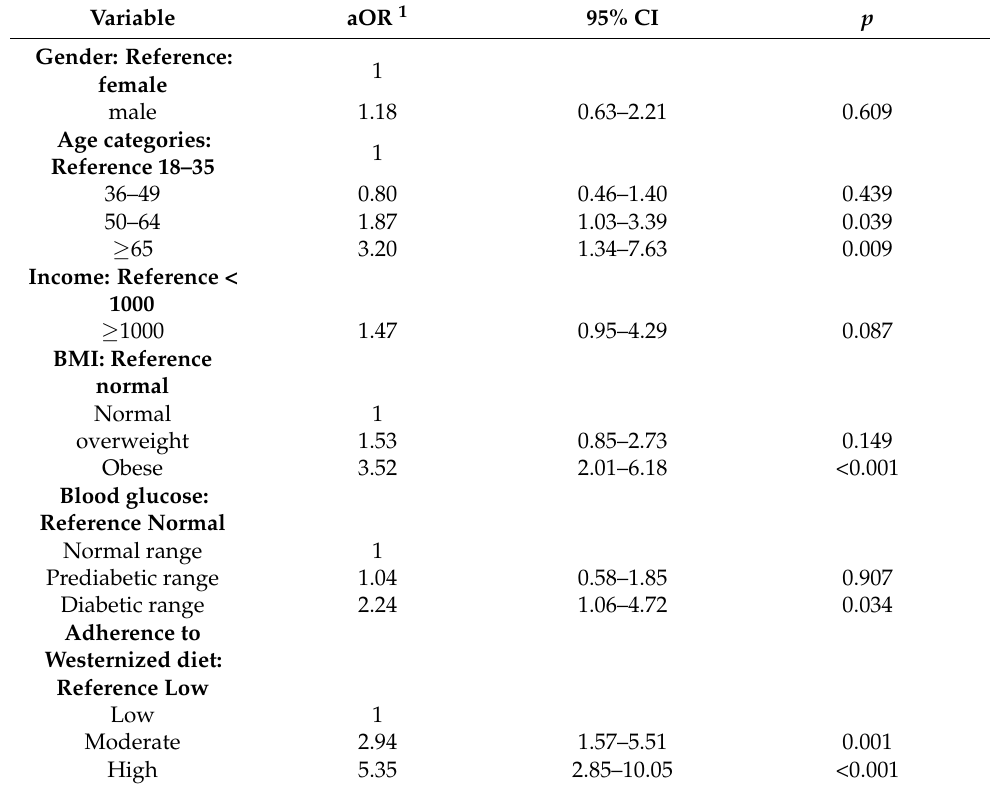
Table 2. Multivariable logistic regression model of sociodemographic and clinical factors associated with